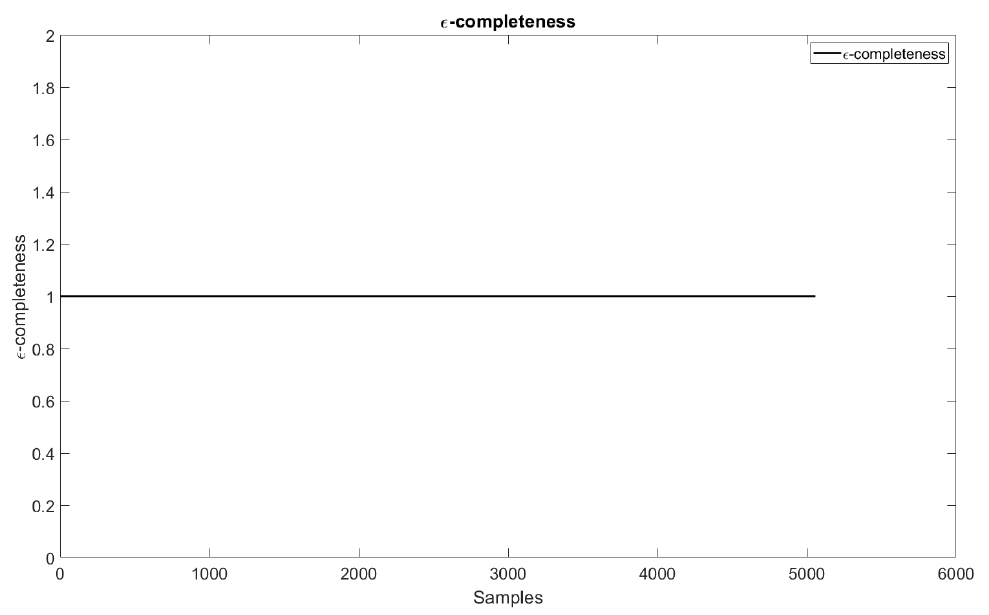
Figure 12. (cid:101) − completeness criteria during the training.